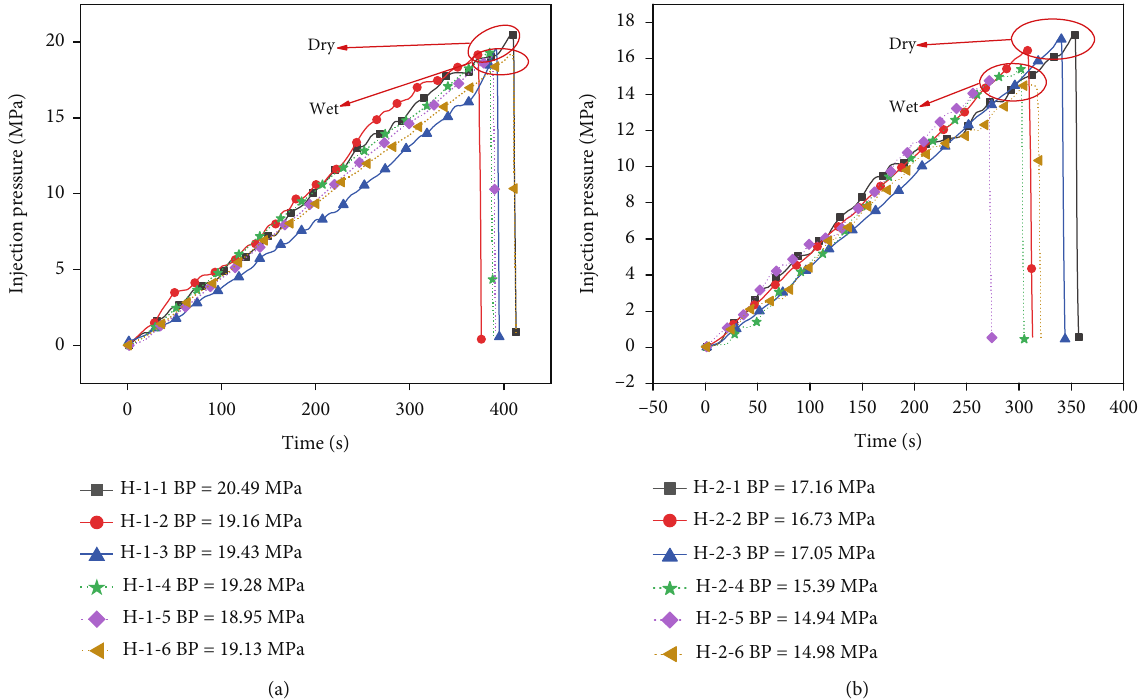
Figure 9: The average breakdown pressure variation and di ff erence between dry and saturated shales after LN di ff erent con fi ning pressures.